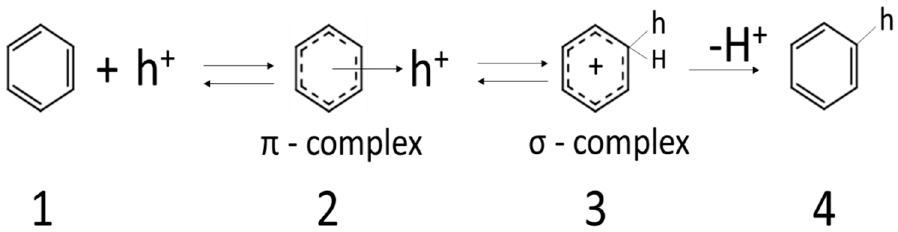
Figure 7. The electrophilic mingling of a positive hole (h + ) with the benzene ring. Step 2 represents the mesomeric/resonance forms in the benzene ring.